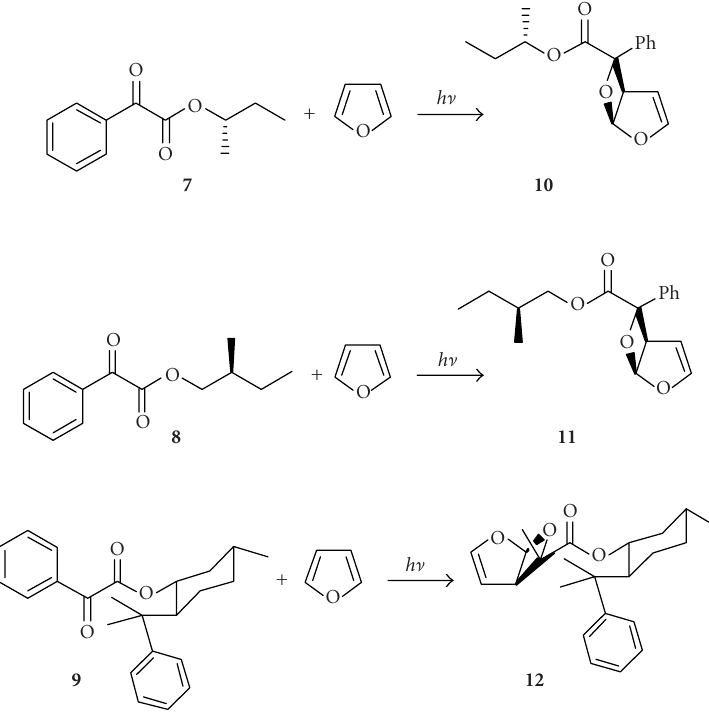
Figure 7: The reaction of chiral phenylglyoxylates with furan.